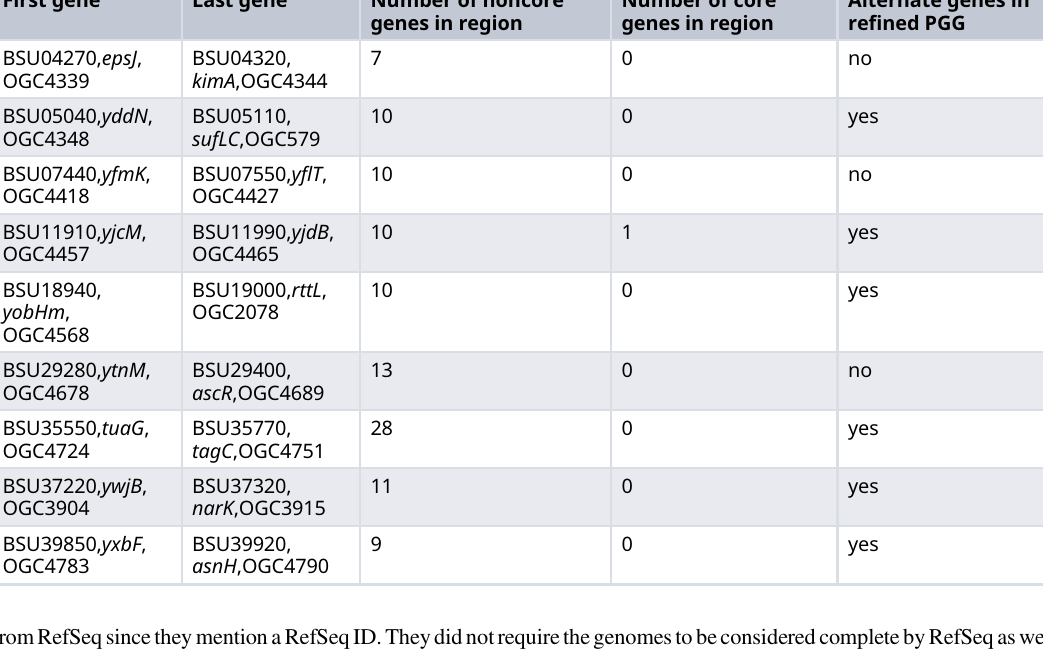
Table 4. Large noncoreregions which havenotbeendeleted from anyof thestrains delta6, IIG-Bs27-47-24, or PG10, PS38. First